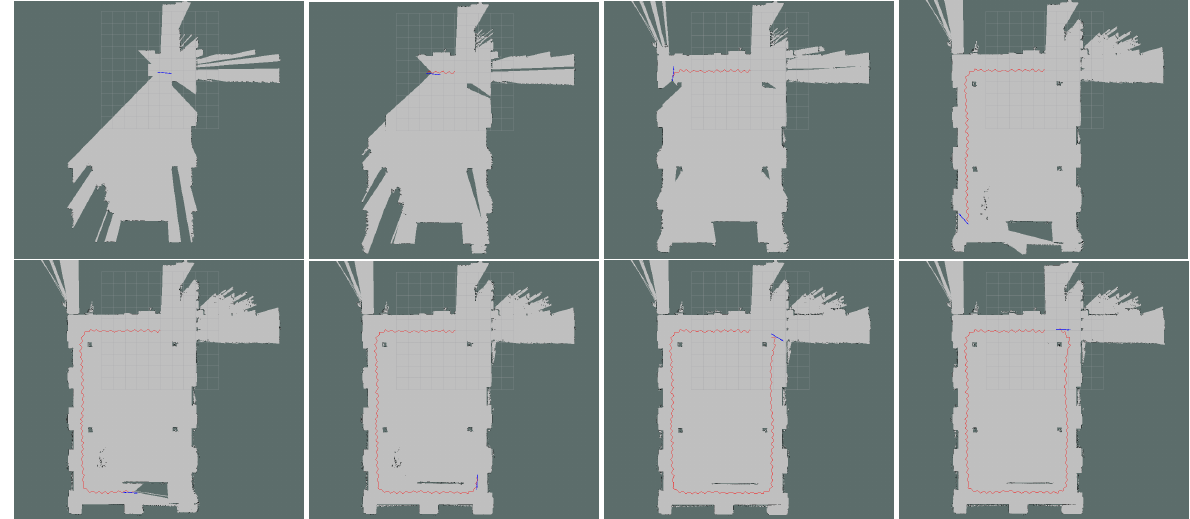
Figure 4. Eight frames showing the 2D map created in the MoLAS scenario (cf. Fig. 1). The red line denotes the trajectory. The superimposed grid has a size of 10 × 10 m 2